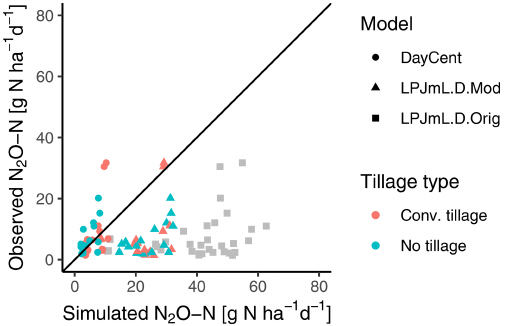
Figure 5. Comparison of observed and simulated yearly averages of N 2 O emissions by tillage type and models DayCent, LPJmL.D.Mod and LPJmL.D.Orig (in gray). The data refer to all four sites and years of the experiments. Each point represents the average of all measured daily values within 1 year and tillage treatment. Tillage types are indicated by different colors.